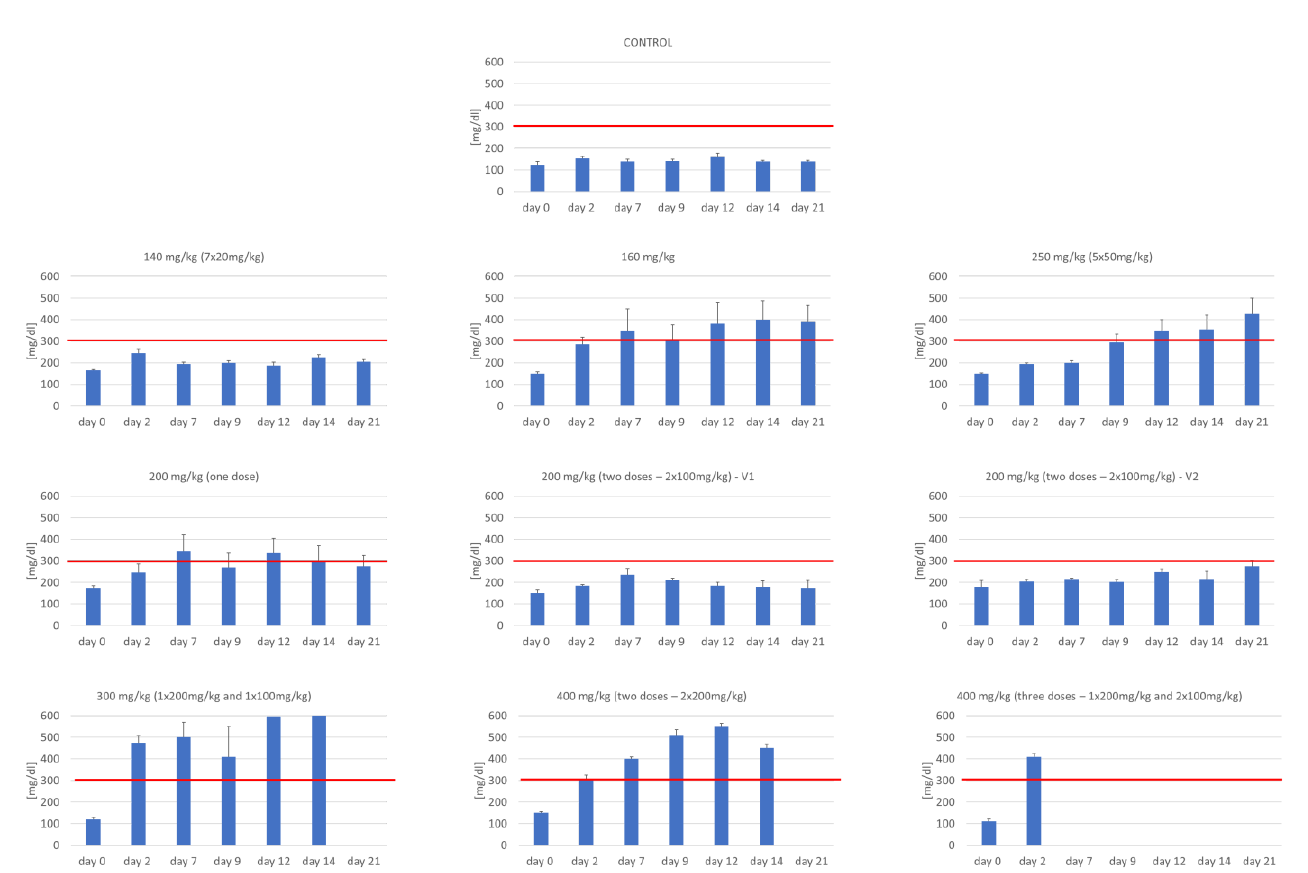
Figure 5. The glucose level in mice after intraperitoneal injection of STZ.